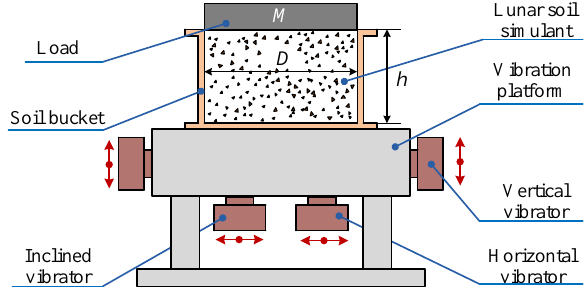
Figure 4. The compaction principle of the three-dimensional vibration.